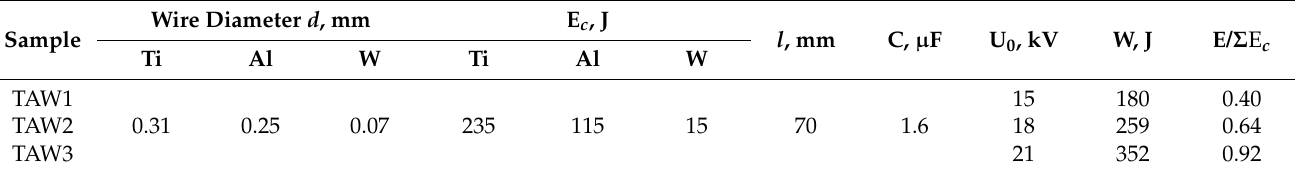
Table 1. EEW parameters.